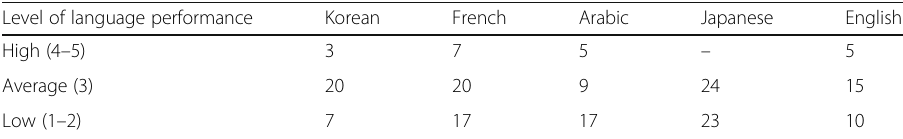
Table 11 Perceived ability when anxious Level of language performance